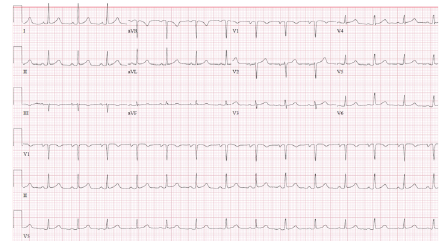
Figure 3: Improved heart rhythm after